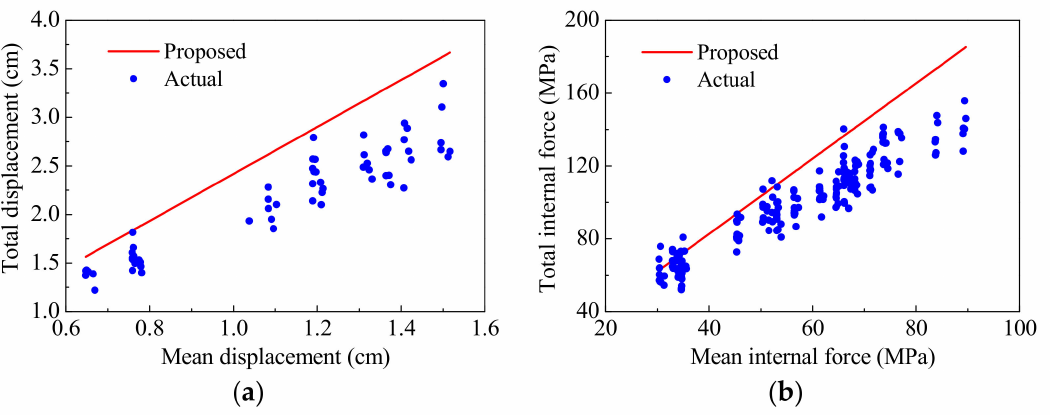
Figure 13. Comparisons of the proposed and actual total responses of the structure: ( a ) nodal displacement; ( b ) elemental internal